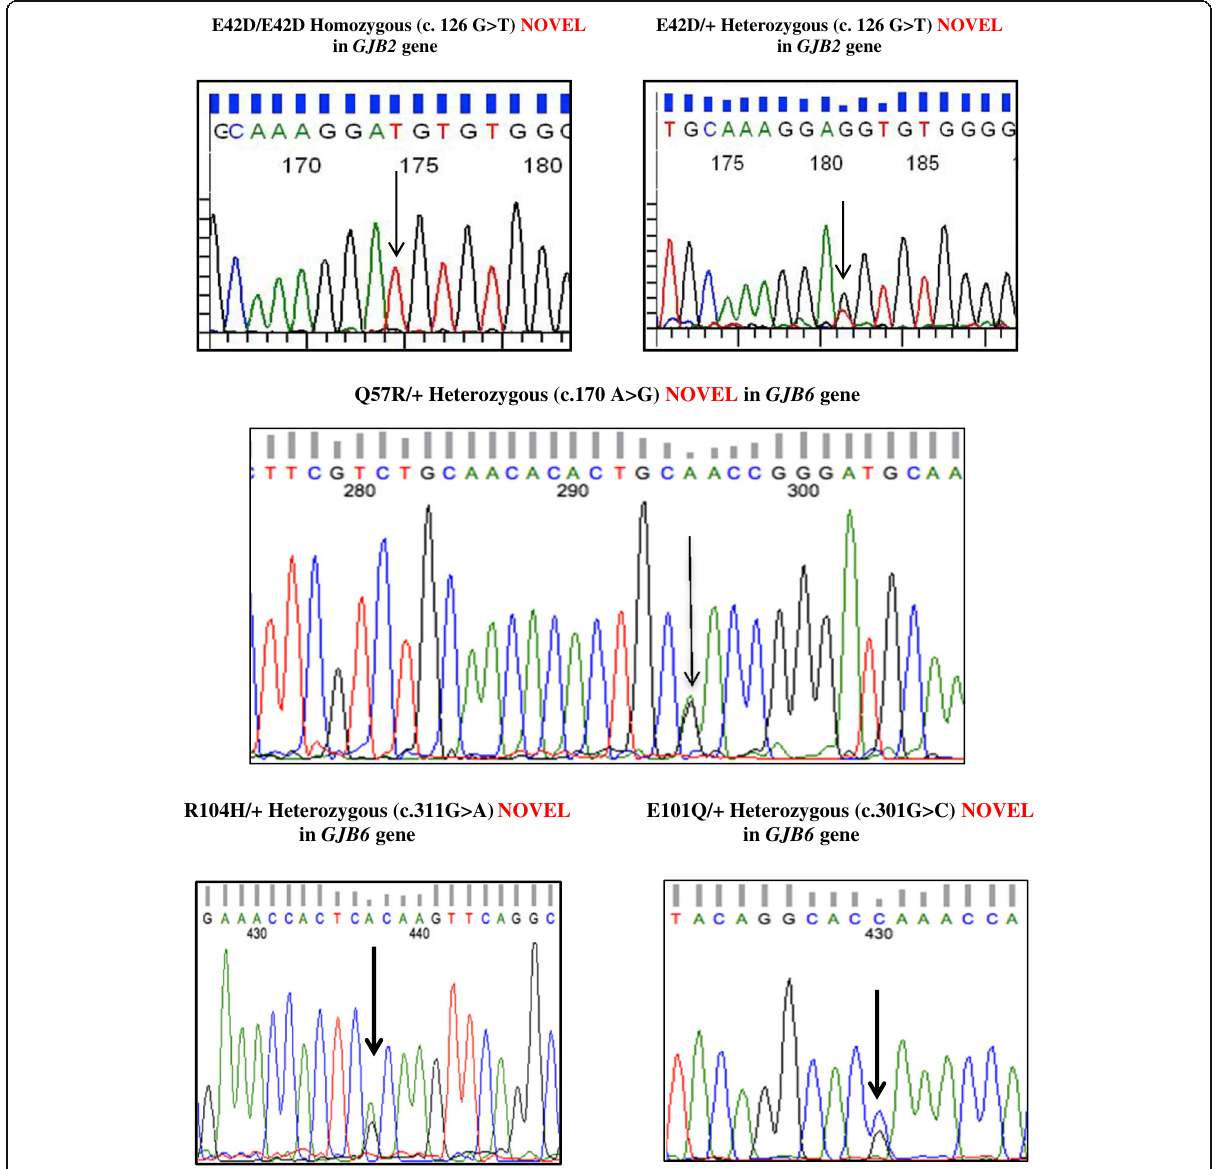
Fig. 1 Partial chromatograms of GJB2 and GJB6 variants observed in the